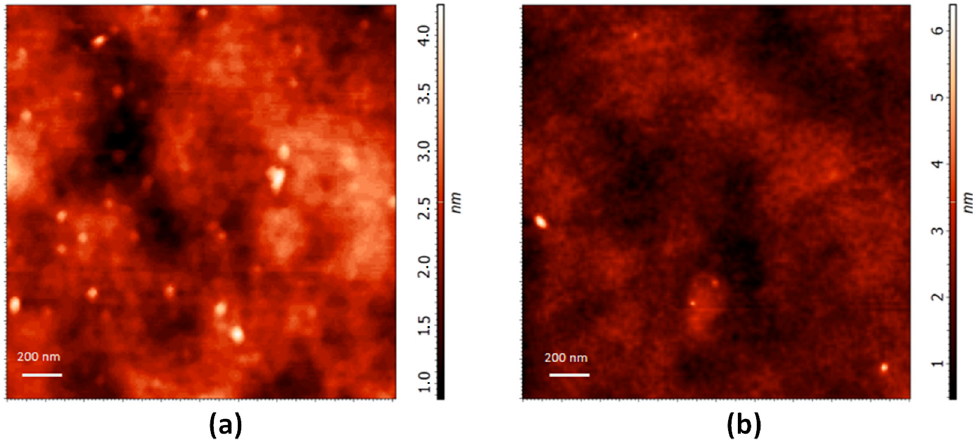
Figure 6. ( a ) AFM image (scan area 2µm × 2µm) of the GQD sample. ( b ) AFM image (scan area 2µm × 2µm) of the GQD-PEG-BFG@Pyr-RF sample.